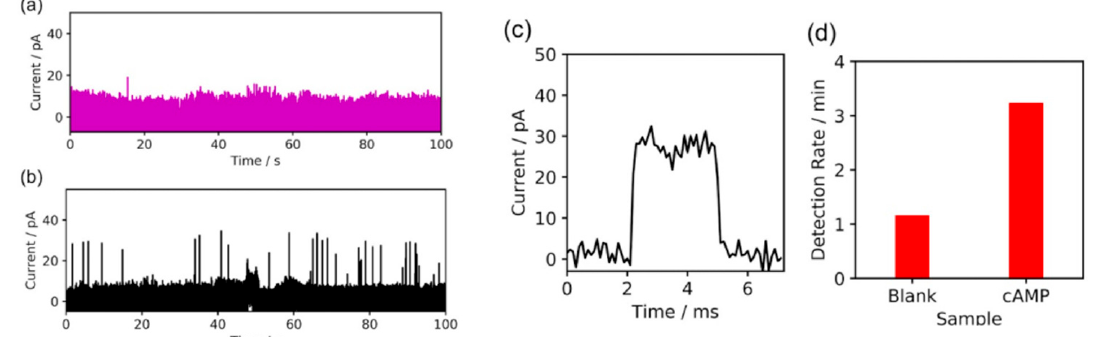
Figure 2. Current–time ( I–t ) profiles for signals obtained in water ( a ), and cAMP aqueous solution ( b ). ( c ) Enlargement of signal shown in ( b ) obtained in cAMP aqueous solution. ( d ) Comparison of signal frequency values for blank and cAMP, respectively. The signal frequencies are clearly different, with the signal frequency of the signals obtained in the cAMP aqueous solution ( right : cAMP) significantly larger than that of the signals obtained in water ( left : blank).